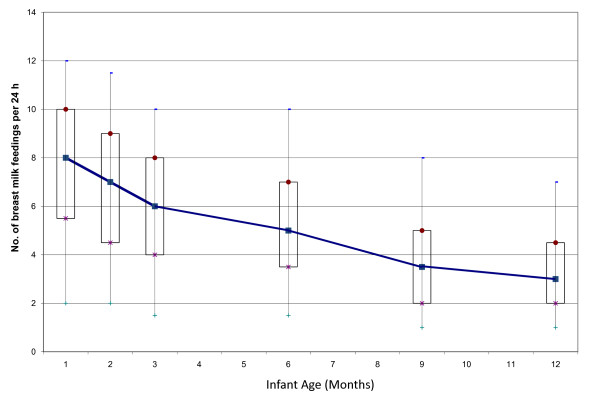
Median, interquartile, and 95th percentile ranges of frequency of breast milk feedings per 24 hours according to infant age. Sample sizes were as follows: 1 month, n = 764; 2 months, n = 516; 3 months, n = 460, 6 months, n = 316; 9 months, n = 227; 12 months, n = 140.